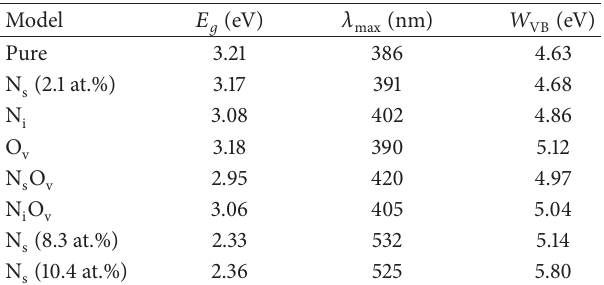
Table 2: Band gap, maximum absorption, wavelength, and width of valence band for various defective models of N-doped TiO